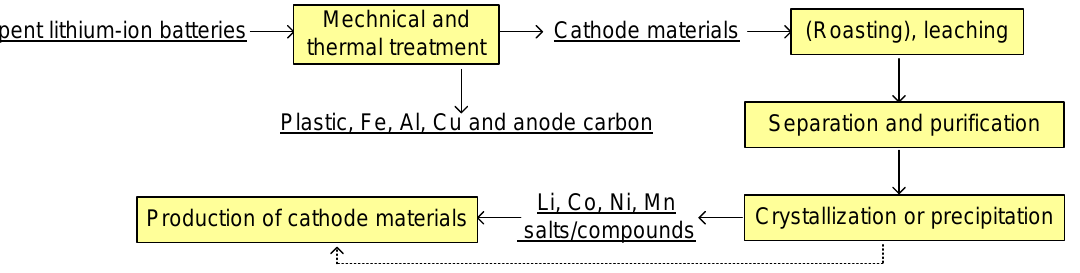
Figure 8. General flowchart for the hydrometallurgical process for recycling of Li-ion batteries.